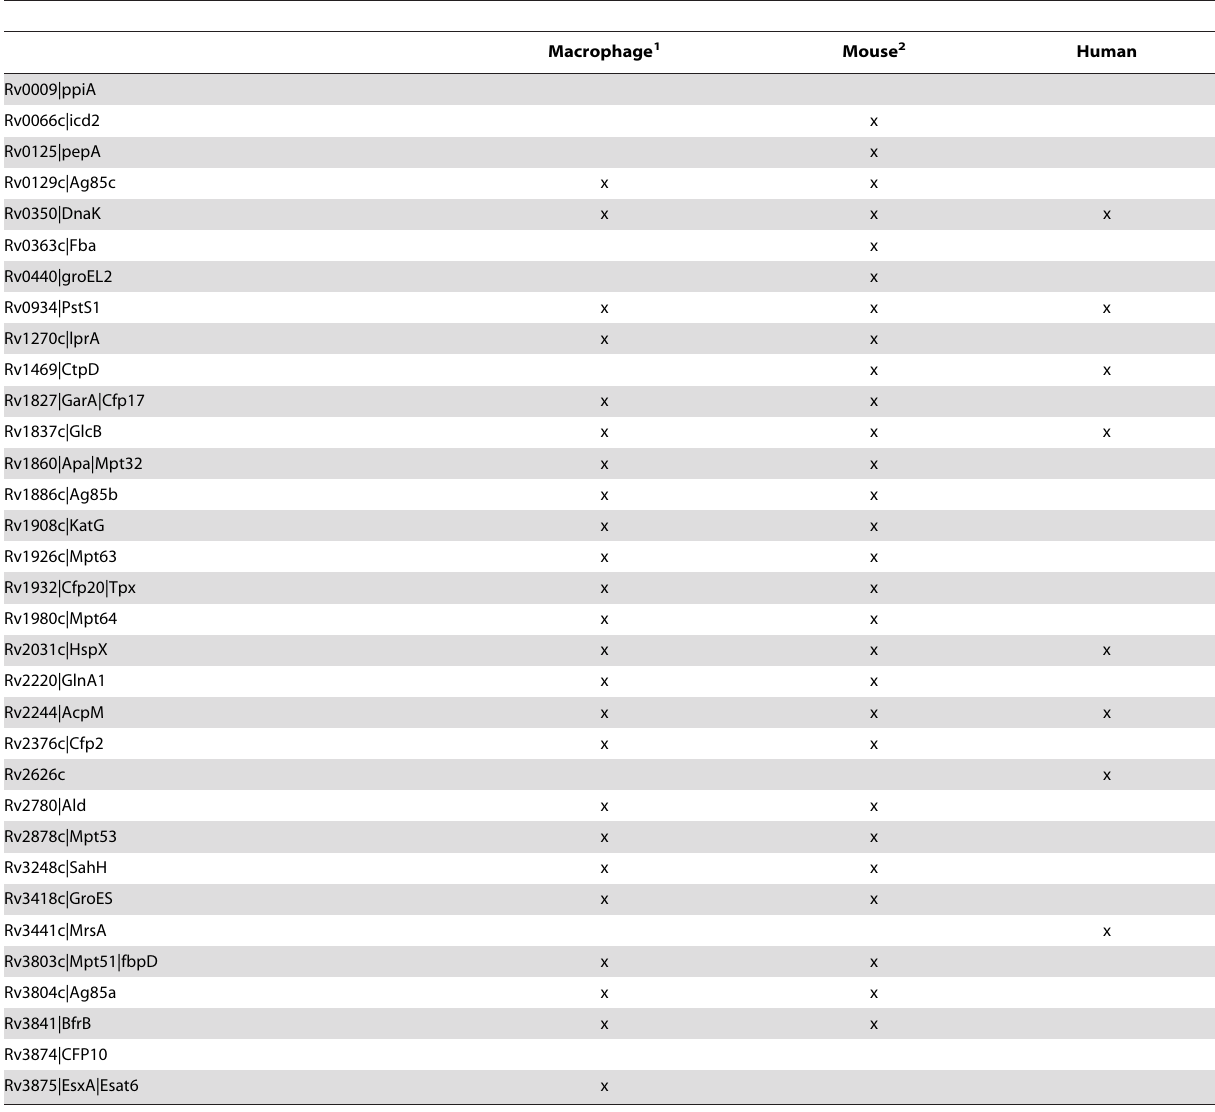
Table 1. Mycobacterial Proteins Included in the Final Seventeen MRM